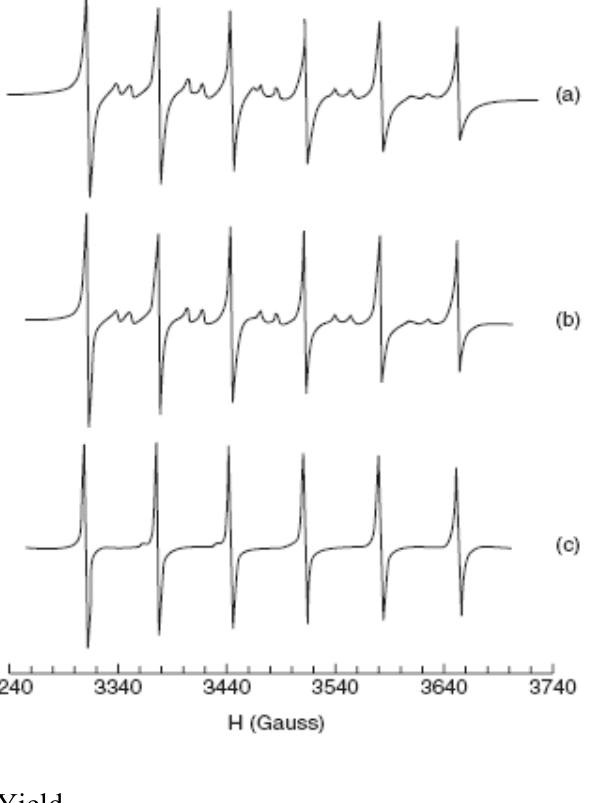
Figure 12. EPR spectra for Mn 2+ in ZnS:Mn sample measured at room temperature; (a), 0.003% Mn 2+ (experimental), (b) 0.008% Mn 2+ (experimental), and (c) 0.008% Mn